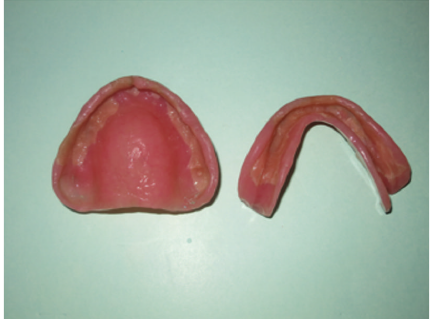
Figure 4: Intaglio surface of relined